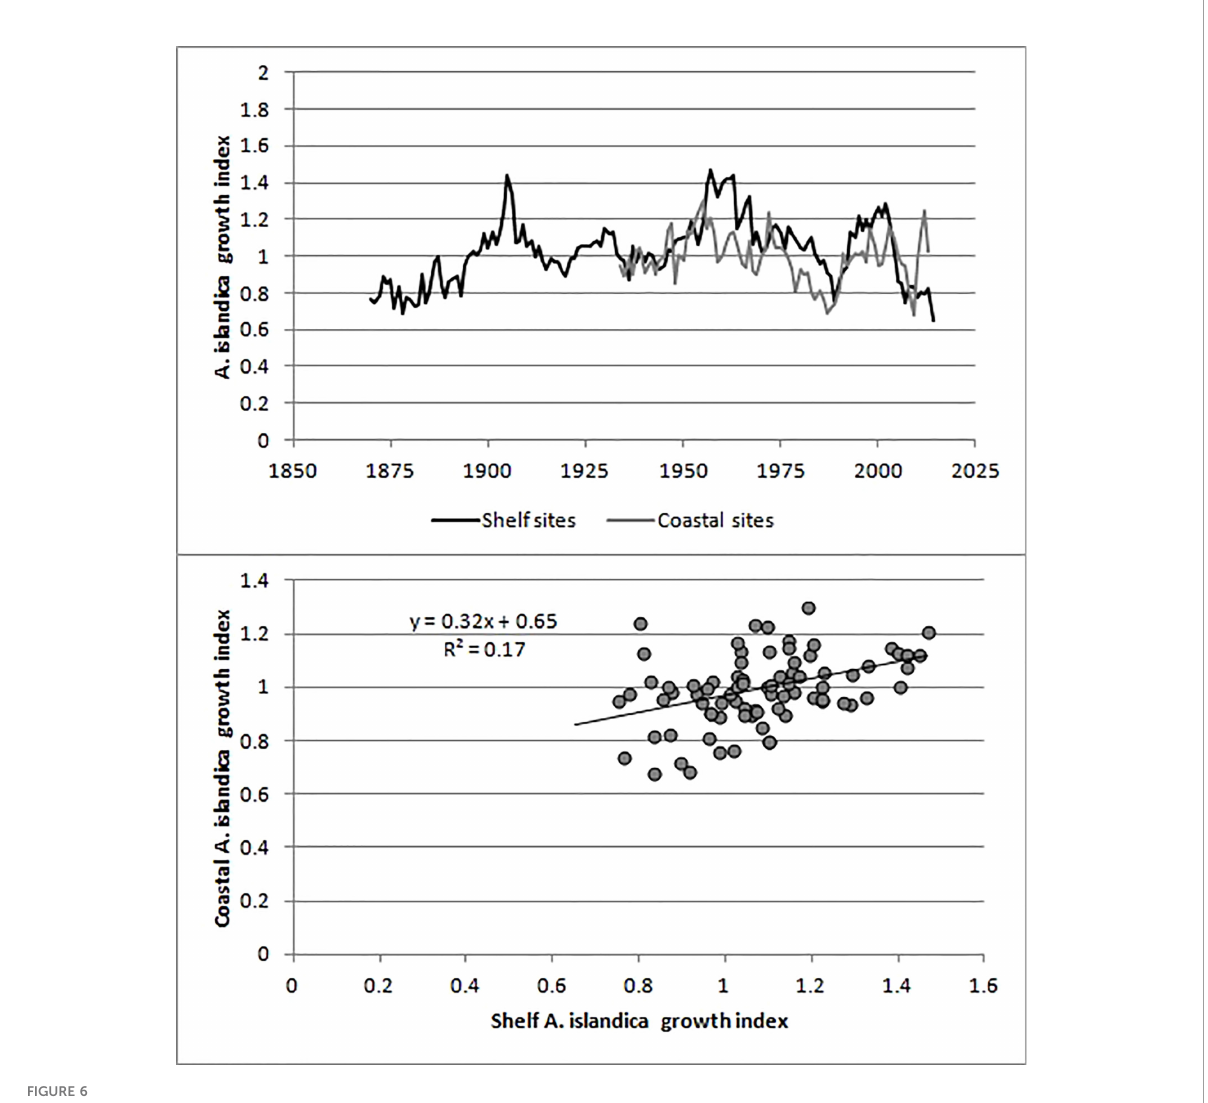
FIGURE 6 Comparison of the shelf and coastal A. islandica growth